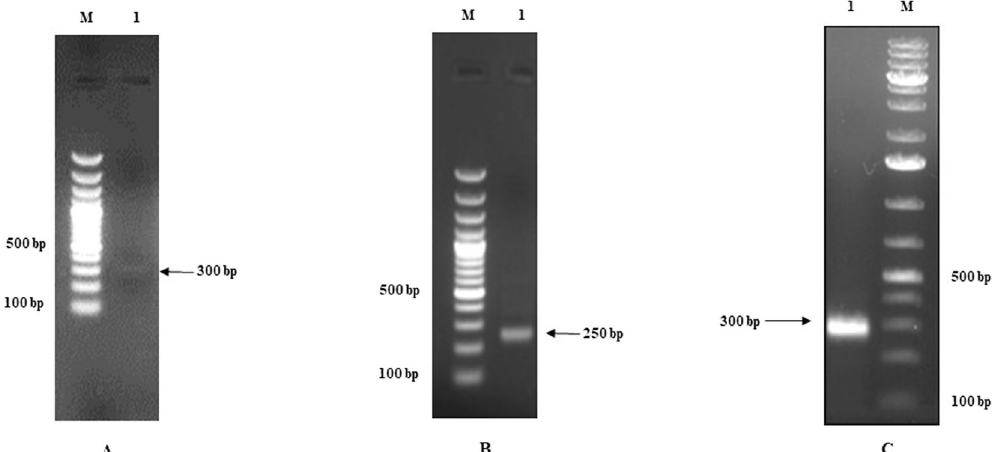
Figure 2. ( A ) Agarose gel Electrophoresis showing RACE amplified products of UL33 gene Lane M: 100bp DNA marker (Thermo scientific). Lane 1: PCR product of 300bp of UL33gene. ( B ) Agarose gel Electrophoresis showing RACE amplified products of UL21 gene. Lane M: 100bp DNA marker (Thermo scientific). Lane 1: PCR product of 250bp of UL21 gene. ( C ) Agarose gel Electrophoresis showing RACE amplified products of UL34 gene Lane M: 100bp DNA marker (Thermo scientific). Lane 1: PCR product of 300bp of UL34